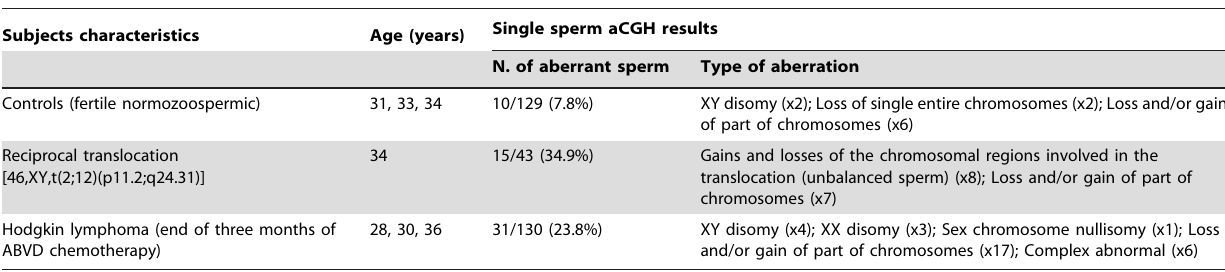
Table 1. Subject characteristics and summary of aCGH results on single